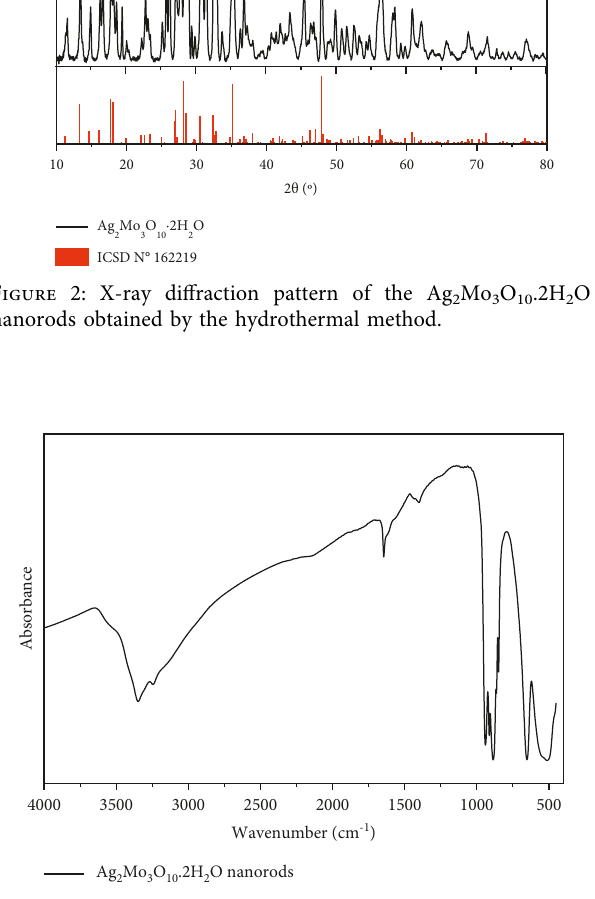
2 Mo 3 O 10 .2H 2 O